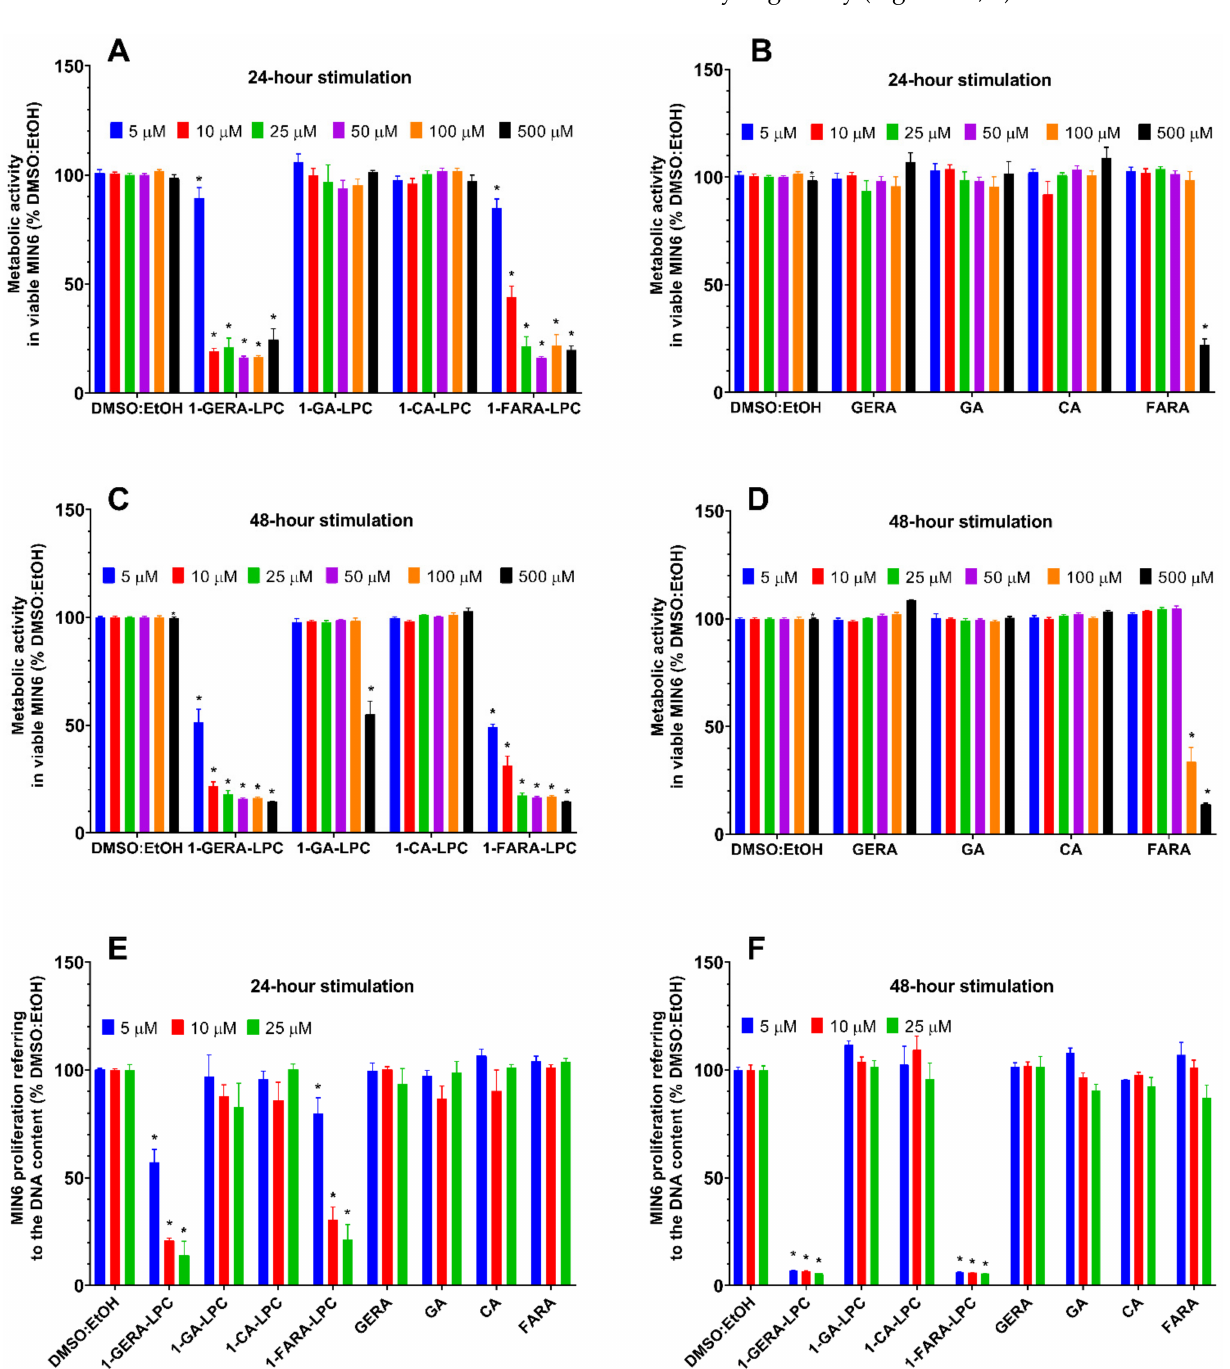
Figure 2. MIN6 cells viability after 24-h ( A , B , E ) and 48-h ( C , D , F ) treatment with 1-GERA-LPC, 1-GA-LPC, 1-CA-LPC, 1-FARA-LPC and corresponding free terpene acids (GERA, GA, CA, FARA). Cytotoxicity was assessed based on the activity of mitochondrial reductases with the PrestoBlue TM Cell Viability Reagent ( A – D ) in the range of 5–500 µ M concentrations ( A – D ). The lowest compound concentrations (5–25 µ M) were re-assessed in cytotoxicity experiments referring to the number of living cells to the quantity of DNA with the CyQUANT TM Cell Proliferation Test ( E , F ). The results are expressed as % of living cells after treatment with respective compounds solvent (DMSO:EtOH) and presented as means ± SEM from 3-4 independent experiments, 3-6 biological replicates each. * p < 0.05 is considered as significantly different from